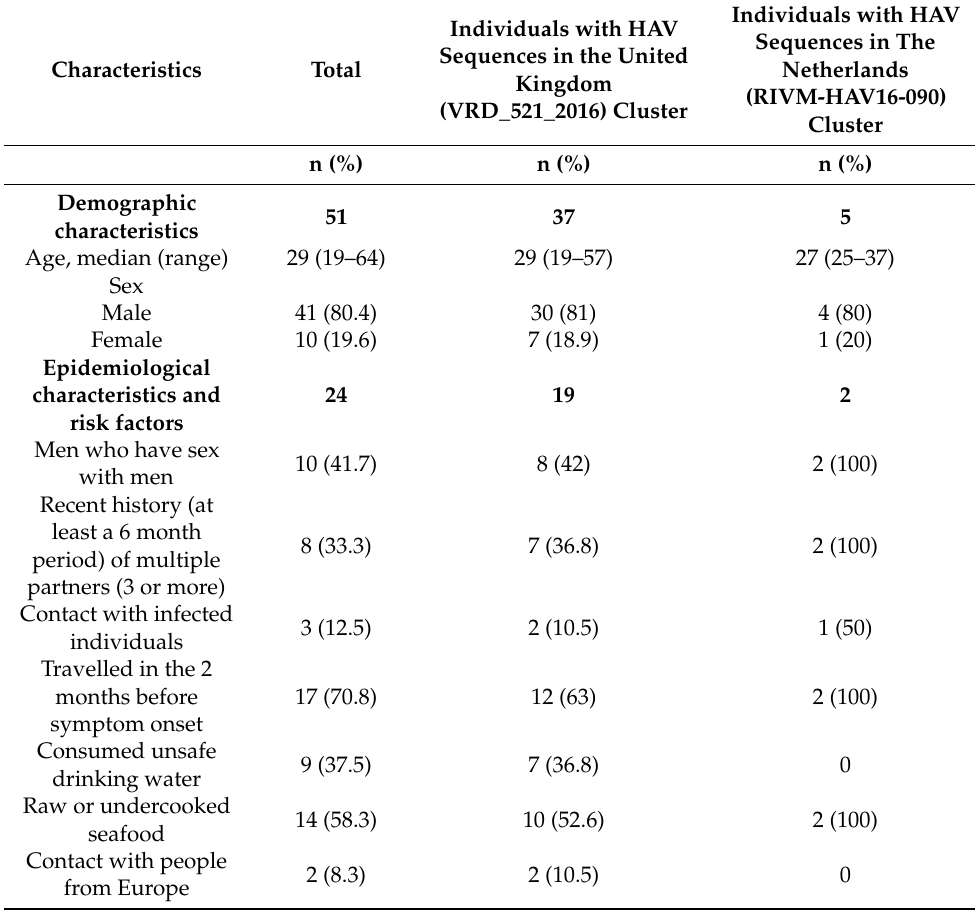
Table 1. Demographic and epidemiological characteristics of acute hepatitis A cases occurring in S ã o Paulo city, Brazil, over the period of September 2017 to May